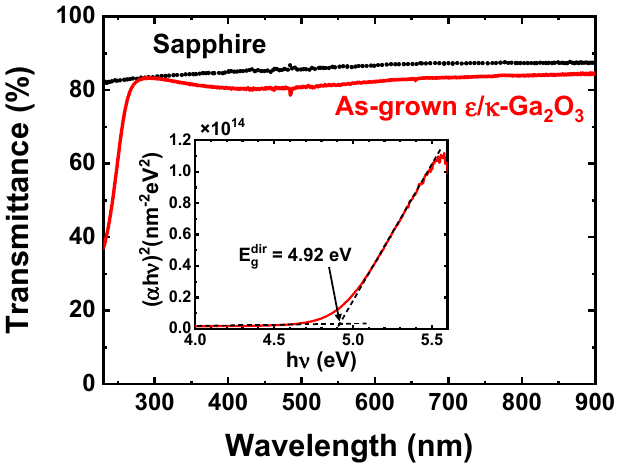
Figure 4. Transmittance spectra of ε / κ -Ga 2 O 3 thin film on a sapphire substrate and bare sapphire substrate. Inset shows a Tauc plot for the direct optical transition of ε / κ -Ga 2 O 3 thin film.